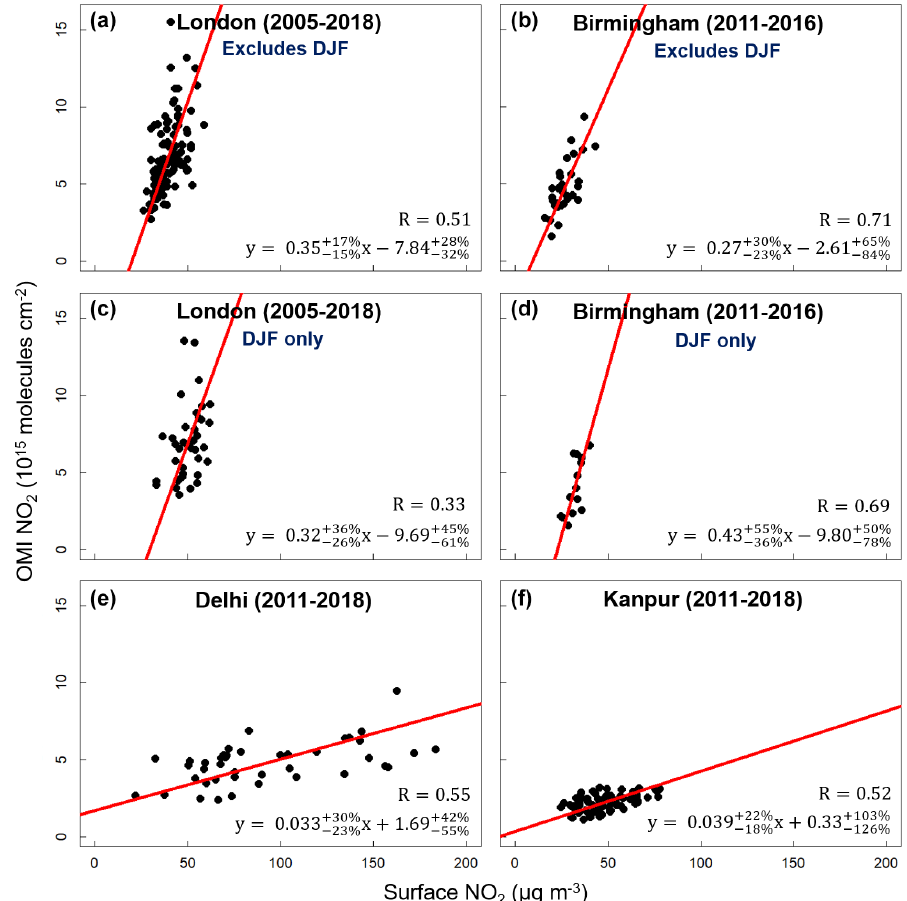
Figure 2. Assessment of OMI NO 2 with ground-based NO 2 . Points are monthly means of city-average NO 2 from OMI and the surface networks for London (a, c) , Birmingham (b, d) , Delhi (e) , and Kanpur (f) . UK cities include panels with all months except December– February (DJF) (a, b) and DJF only (c, d) . Data for all months are given for cities in India. The red line is the standard major axis (SMA) regression. Values inset are Pearson’s correlation coefficients and regression statistics. Relative errors on the slopes and intercepts are the 95% confidence interval (CI).